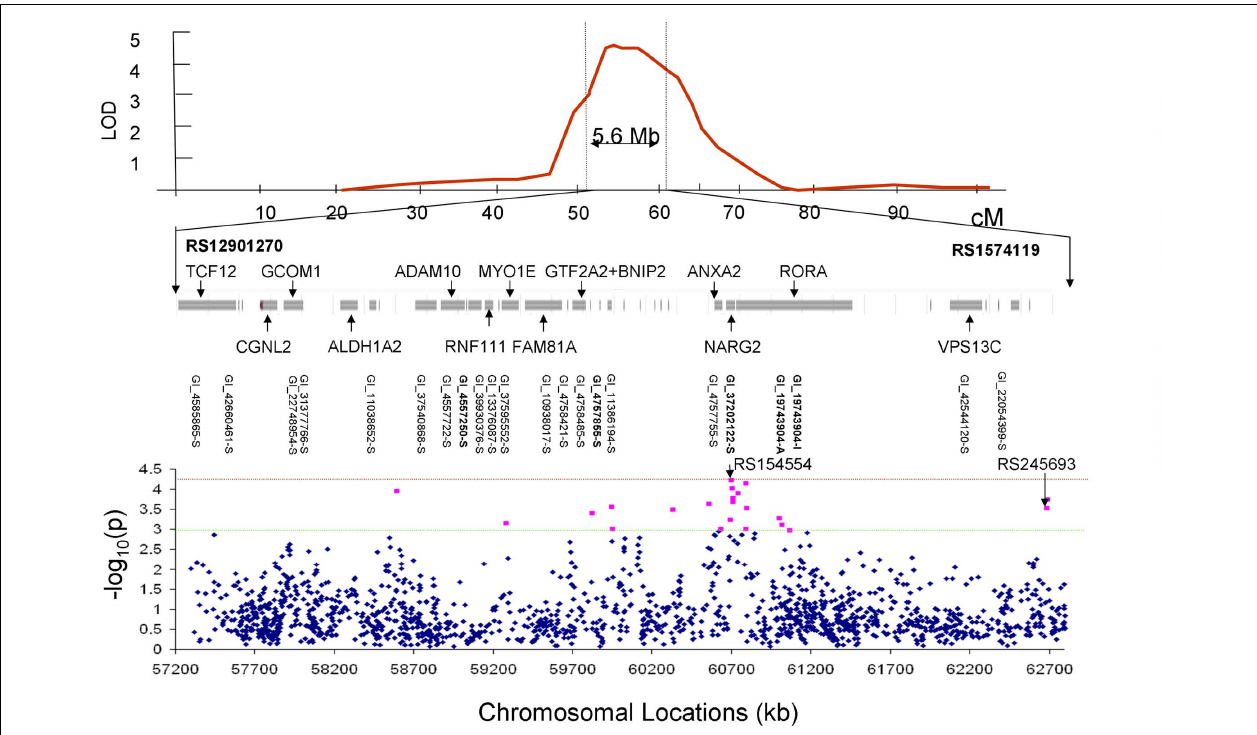
analysis for 1565 SNPs located under the linkage peak are plotted along the x -axis (bottom).The red line corresponds to the significant evidence value of p = 5 · 10 − 5 .The green line corresponds to the suggestive evidence value of p = 1 · 10 − 3